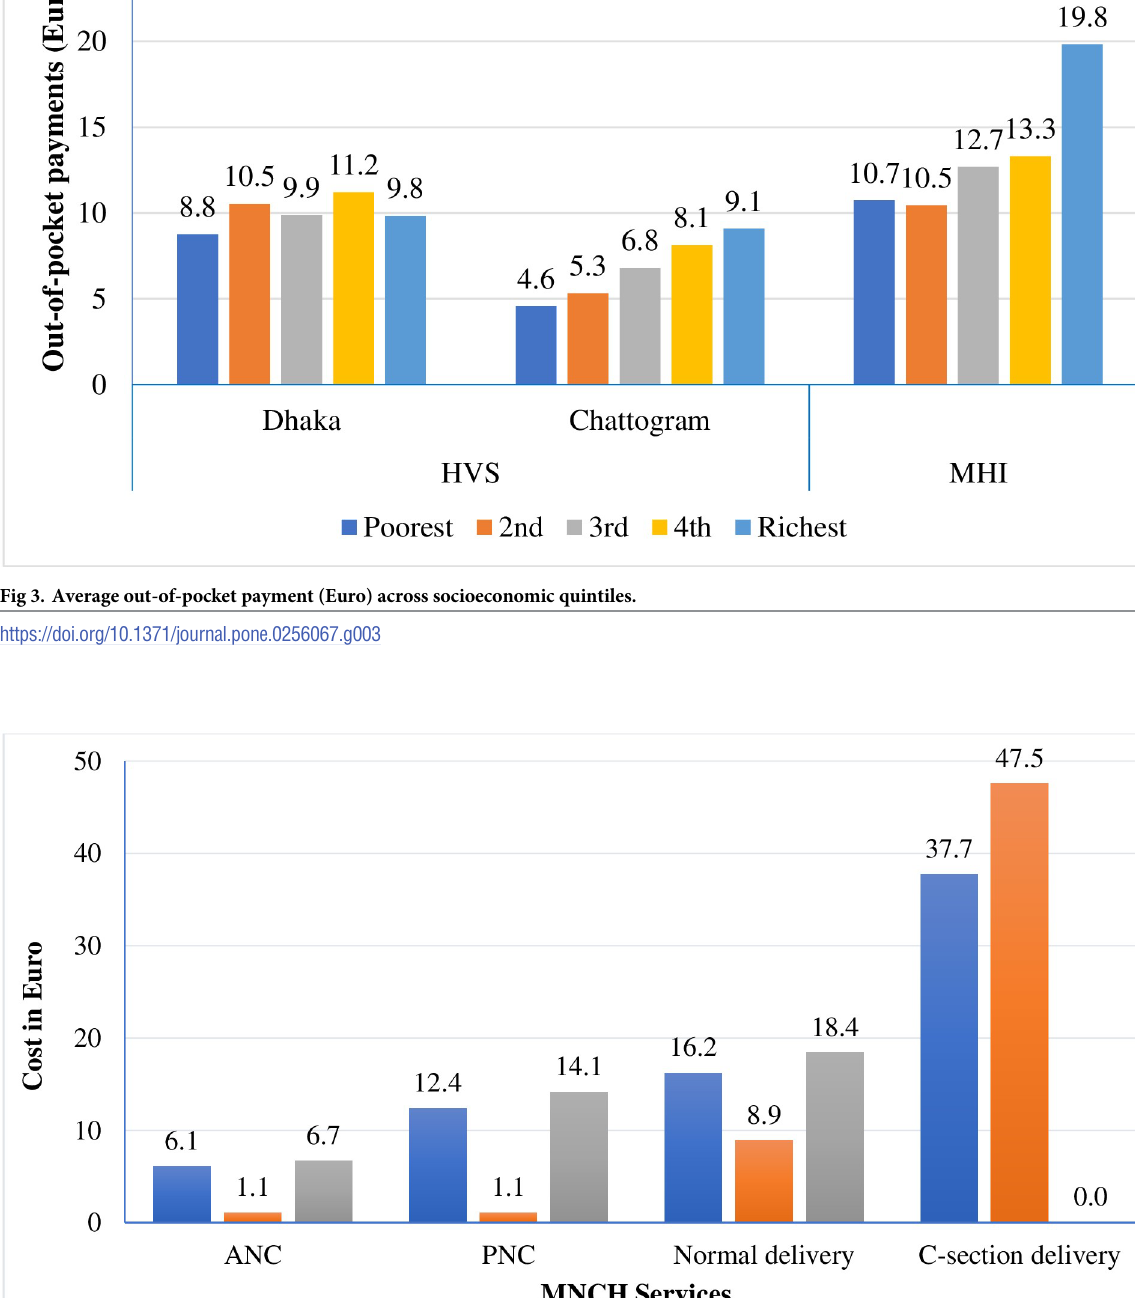
PLOS ONE | https://doi.org/10.1371/journal.pone.0256067 November1,